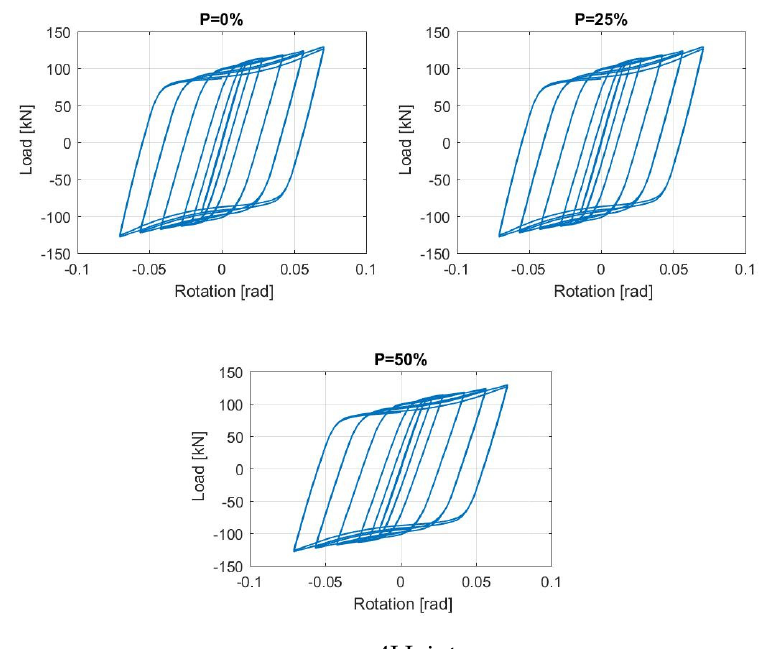
Figure 12. Summary of Load-displacement curve according to Equivalent Load Method in joints. Note: P, is the axial load applied in numerical model, Py = FyAg, where Fy is the plastic modulus and Ag is the gross area.